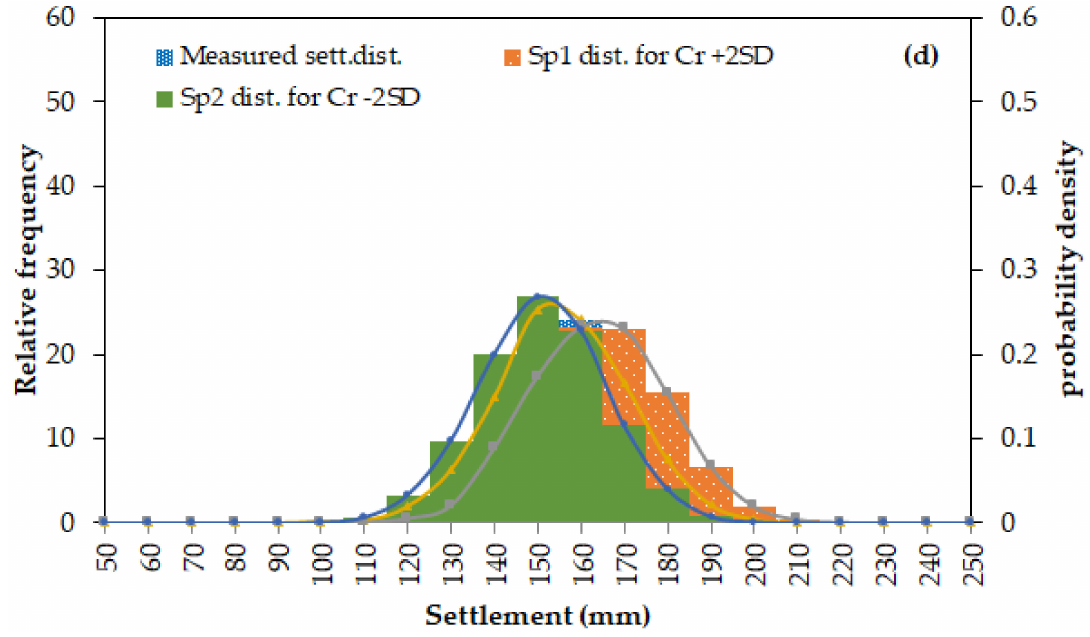
Figure 13. Uncertainty distribution of ultimate consolidation settlement for ( a ) k v ( b ) C α ( c ) C c and ( d ) C r –Ballina